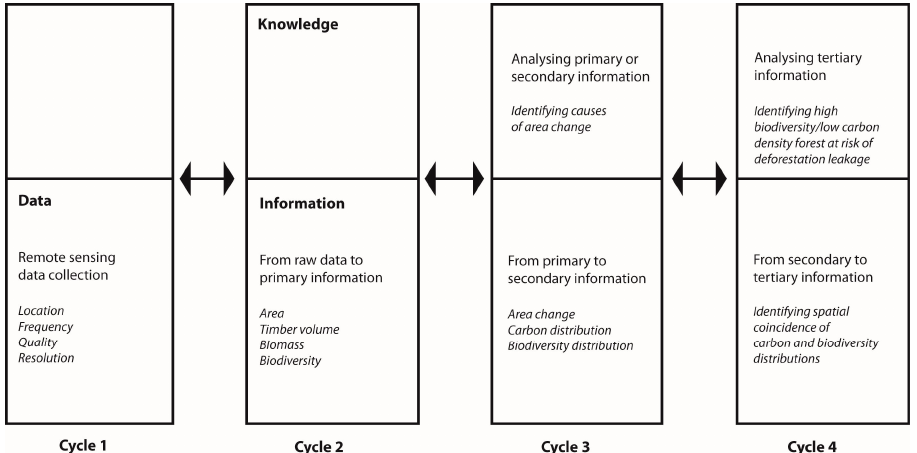
Figure 2. The Knowledge Exchange Chain framework, comprising a series of cycles that convert data into primary, secondary and tertiary information and knowledge [13].